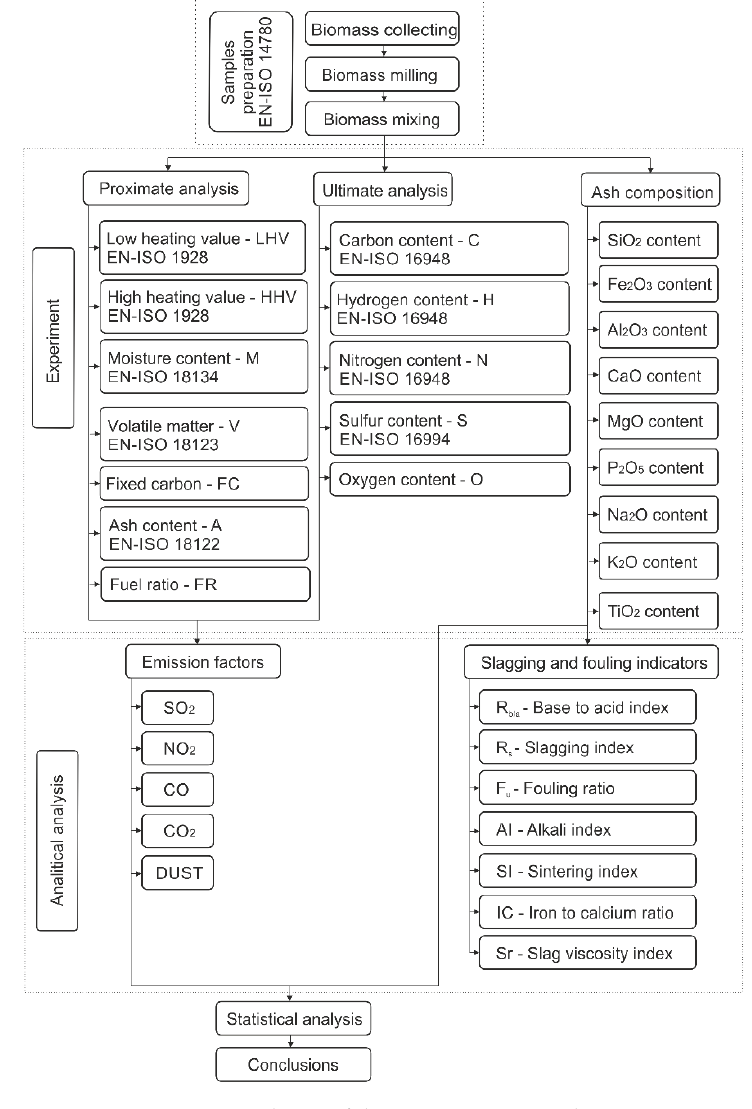
Figure 2. Scheme of the experiment procedure.